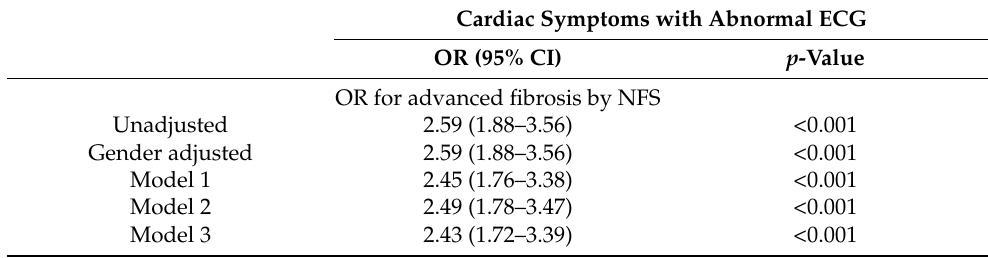
Table 4. Adjusted odds ratios of the presence of cardiac symptoms with abnormal electrocardiograms for advanced liver fibrosis defined using the NAFLD fibrosis score and fibrosis-4